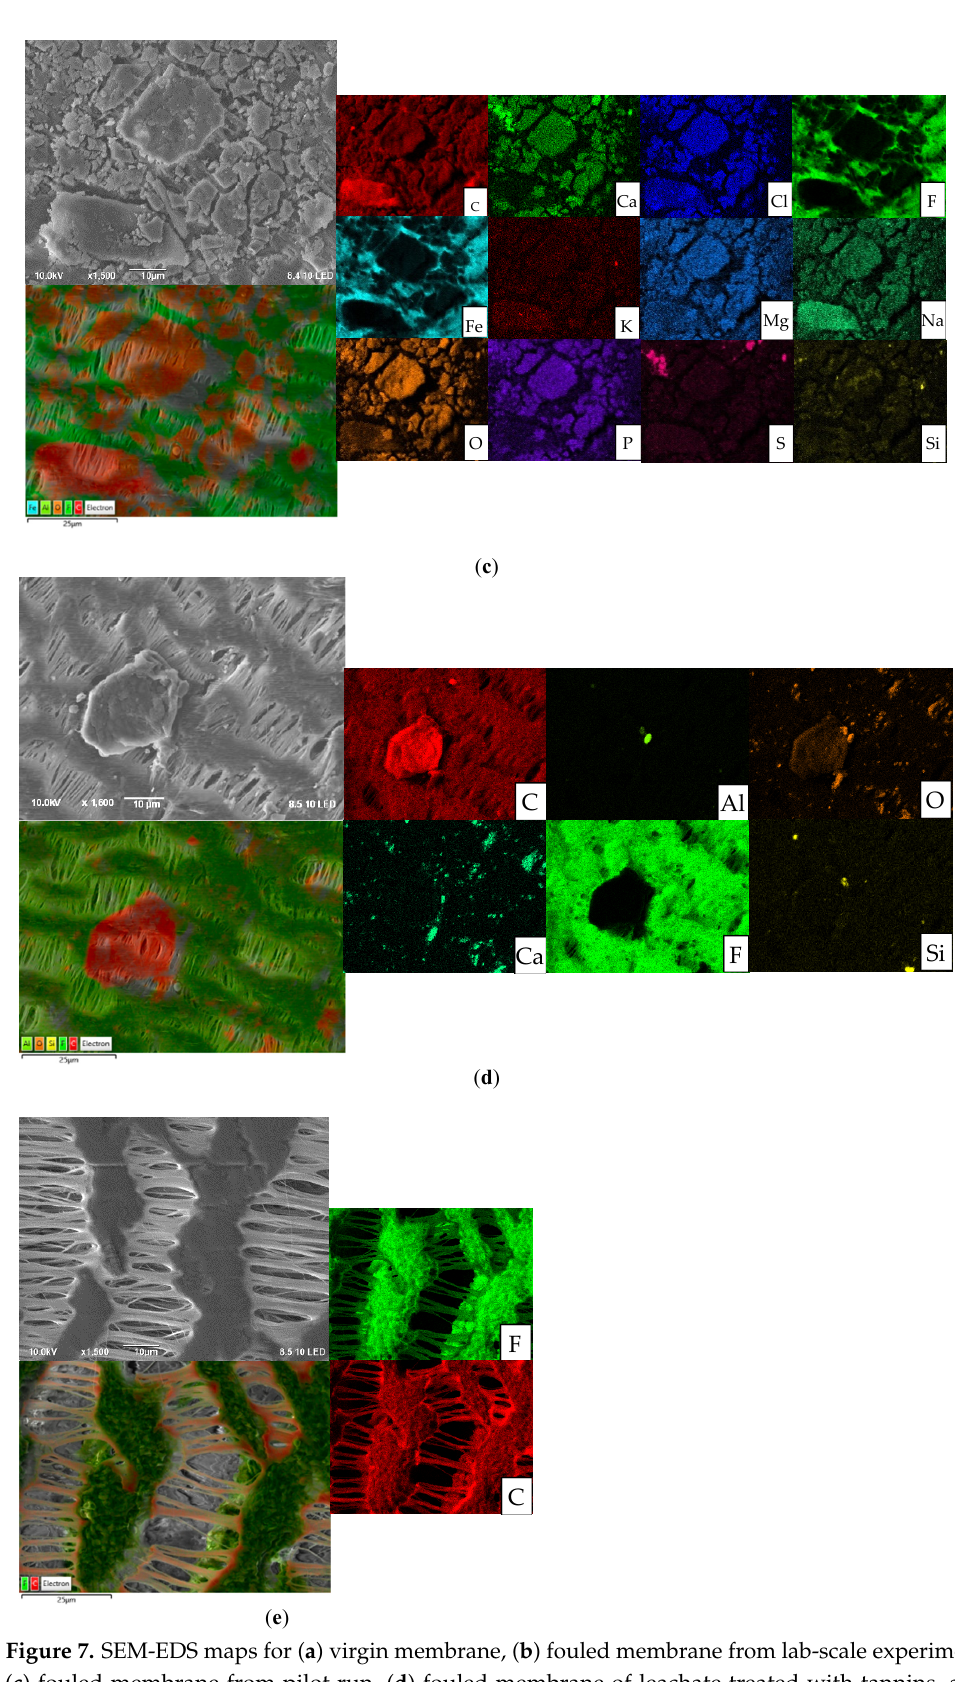
Figure 8. Ammonia flux of untreated leachate vs. treated leachate using a cleaned membrane with UV+H 2 O 2 . Further investigation into the chemical structure of the fouling layer was performed using an FTIR analysis of the membrane samples, as shown in Figure 9. The virgin mem- brane exhibited the typical four characteristic peaks of PTFE. The peaks around 1150 cm − 1 and 1200 cm − 1 were associated with the vibration of the -CF 2 and -CF 3 groups [37]. The peaks at 500 cm − 1 , 550 cm − 1 , and 650 cm − 1 were related to the bending modes of the -CF 2 group [38]. The reduction in the intensity of these peaks suggested the accumulation of a fouling layer on the membrane, as is the case with fouled membranes. Some of the inten- sity of these peaks was restored with the treated leachate. However, the intensity of the characteristic peaks for the cleaned membrane were slightly higher compared to that for the virgin membrane. As explained earlier, this could have been due to the effective clean- ing of UV+H 2 O 2 , which could have even removed particles adhered onto the virgin mem- brane surface during the manufacturing or shipping stages. The main peaks that appeared 0